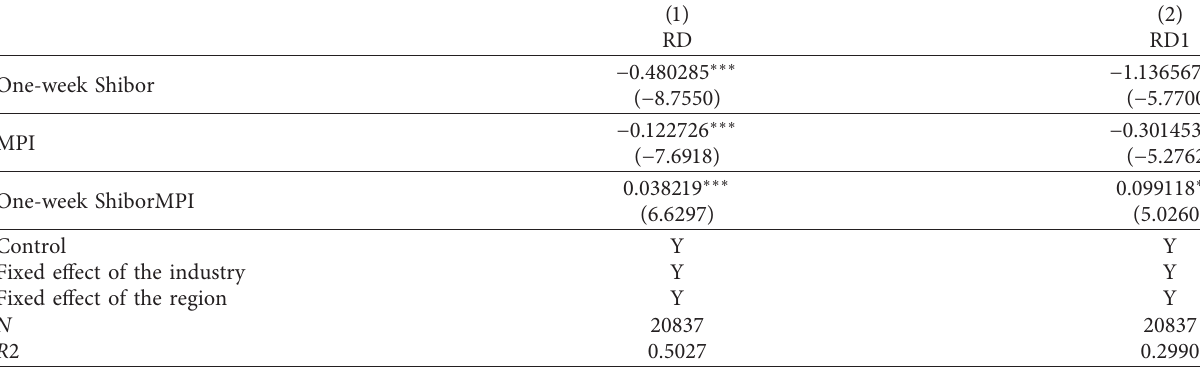
Table 6: Robustness